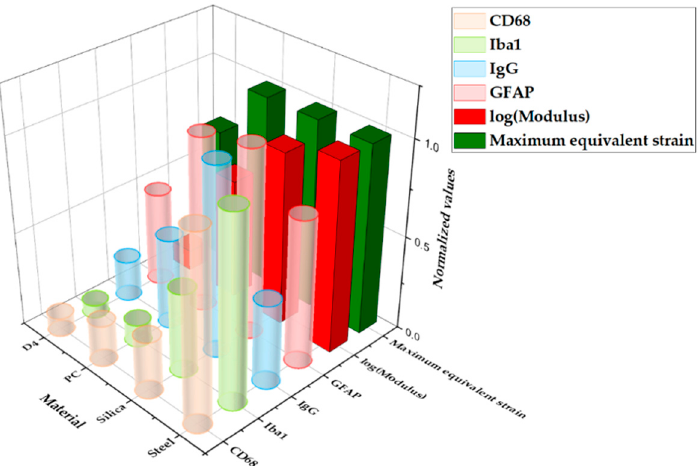
Figure 13. Three-dimensional ( 3D) plot summarizing the main results from the computational and histological analyses varying the base materials: steel, silica, PC, and hydrogel. All values were normalized with the maximum value in the group.